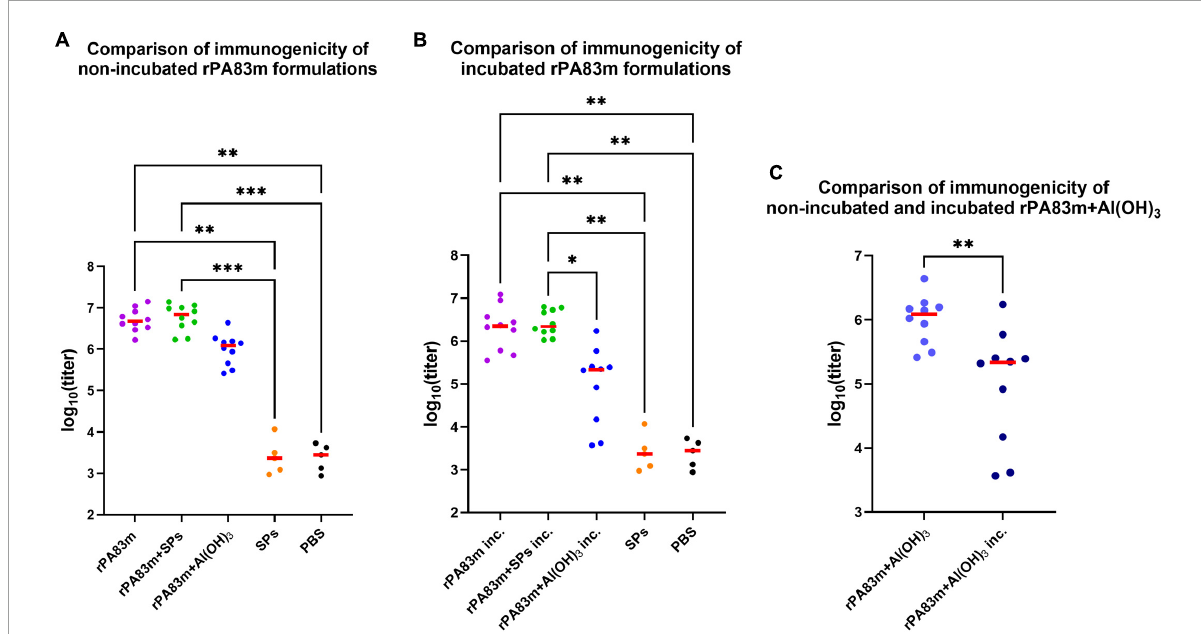
, titres of mice; – , median. (cid:32)